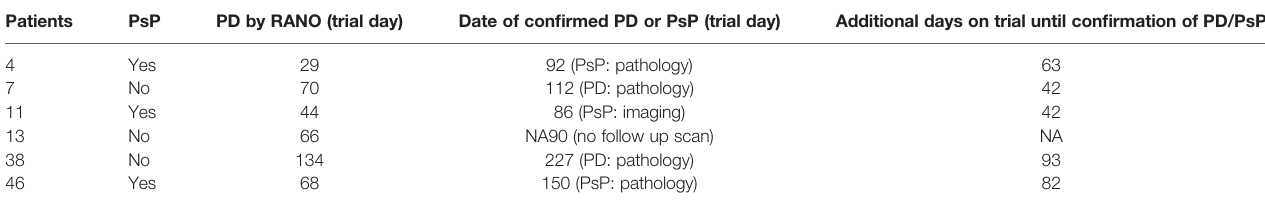
Pathology denotes disease diagnosed by pathology specimen which revealed predominantly necrosis, in fl ammation, and/or other treatment-related effects. PsP, pseudoprogression; NA, not available.